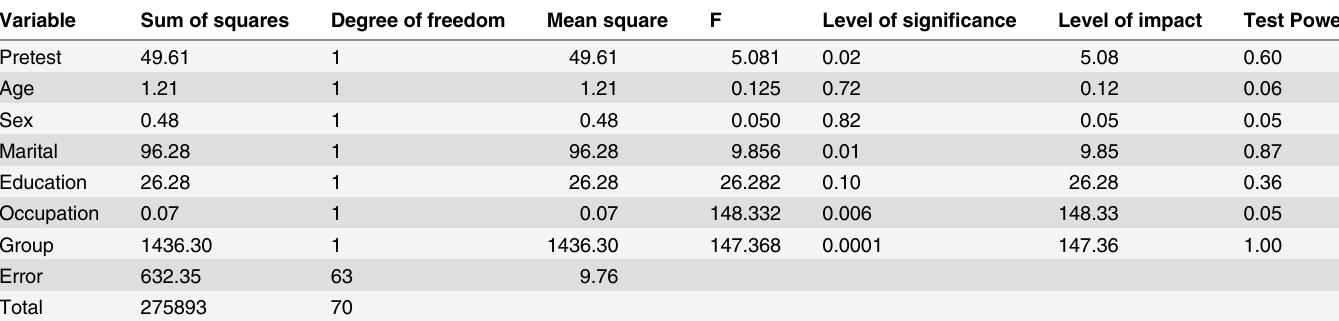
Table 4. The Mean Scores of Pretest and Posttest of Awareness about Self-Care Behaviors in Study Groups, Based on ANCOVA Results. Variable Sum of squares